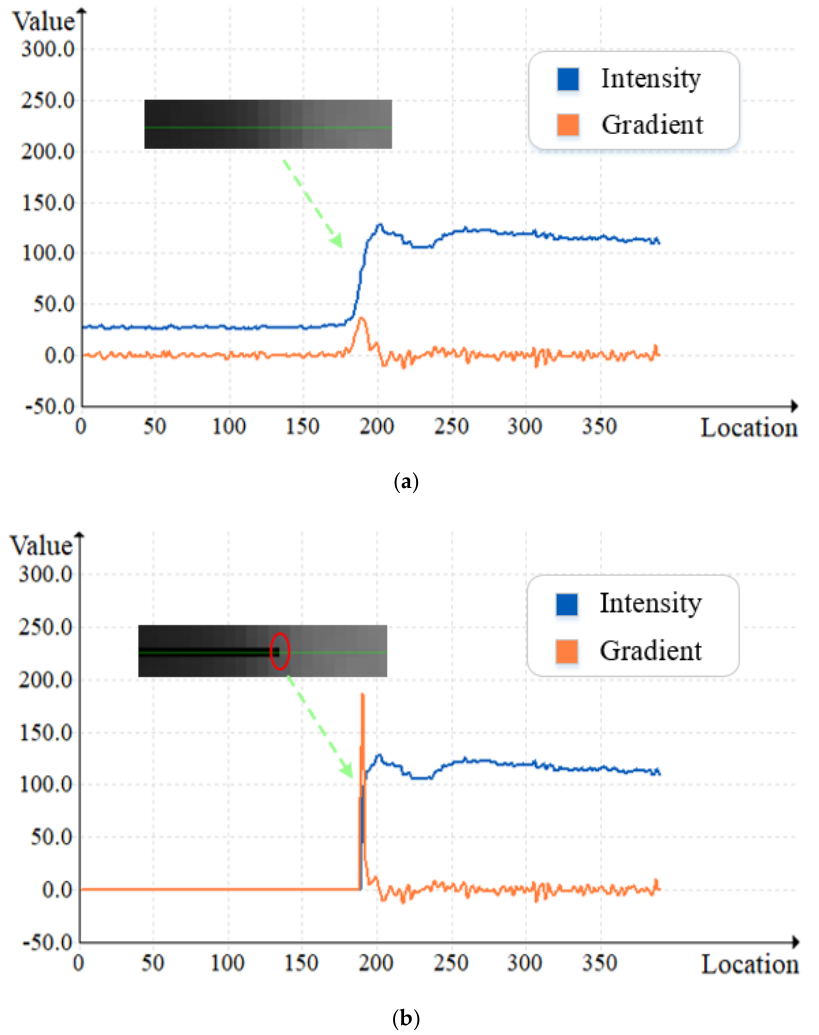
Figure 8. Grayscale value and corresponding gradient of pixels in Line ROI: ( a ) the result of grayscale value gradient calculation of the image in the original state; ( b ) the image style and grayscale value gradient calculation of the original pixels after threshold segmentation.